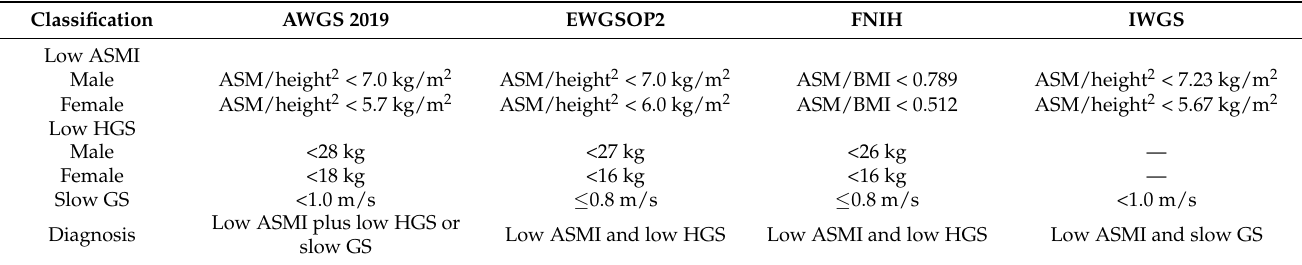
Table 1. Classifications and cut-off values to define sarcopenia in this